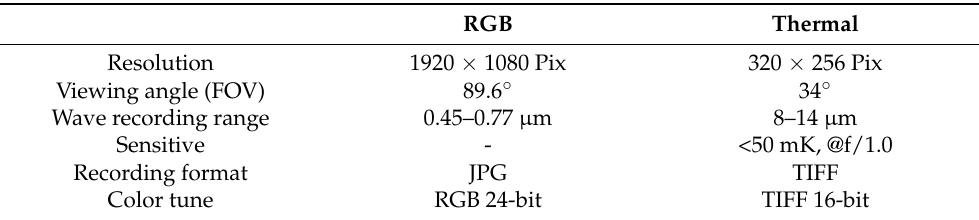
Table 2. Spatial differentiation of products made in Agisoft Metashape [49]. Elevation model of land cover Orthophotomap 7.71